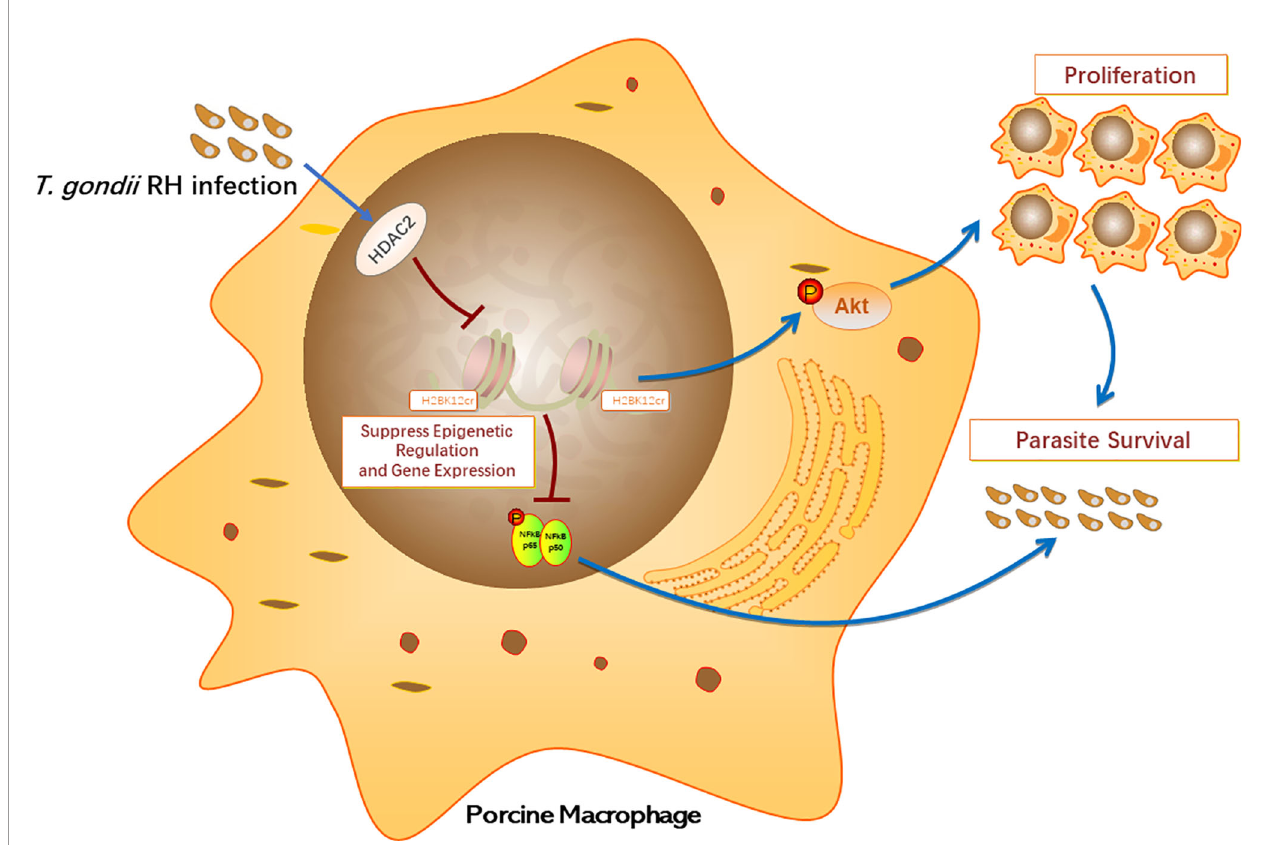
FIGURE 9 | Schematic diagram of biological functions of histone crotonylation in the immune response of porcine alveolar macrophages against T. gondii